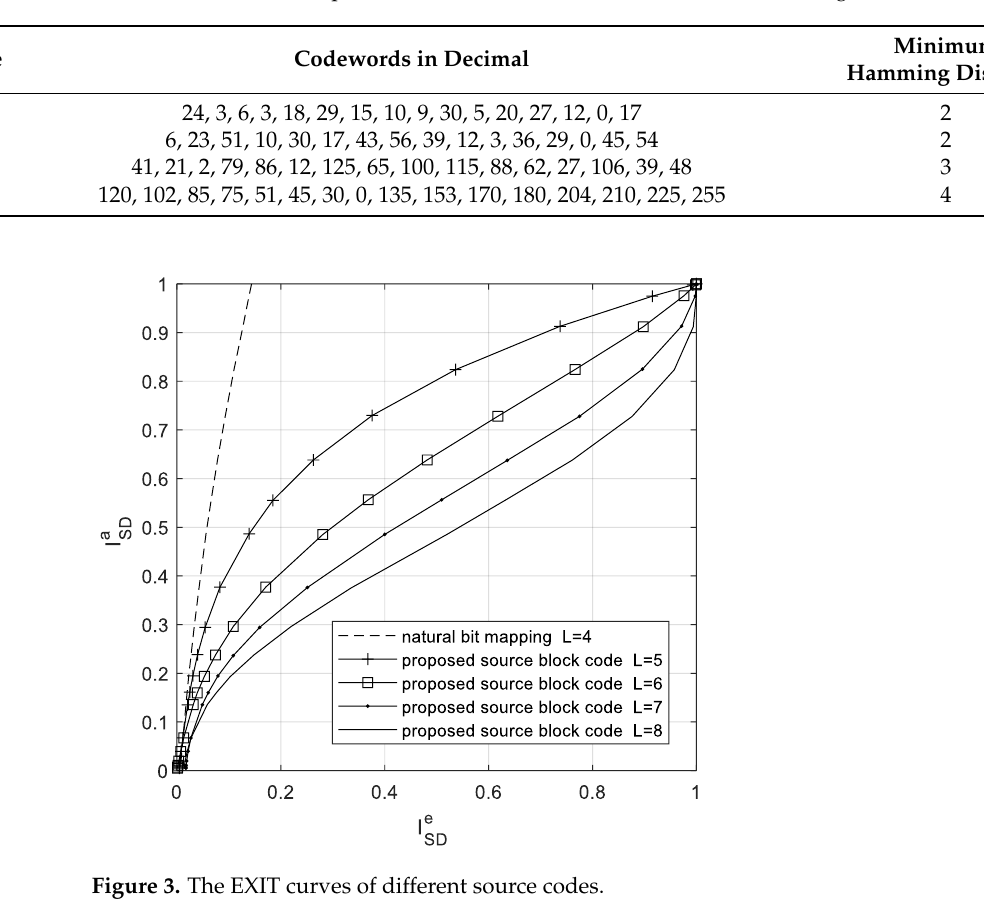
Table 1. Parameters of optimized source codewords with different code lengths.